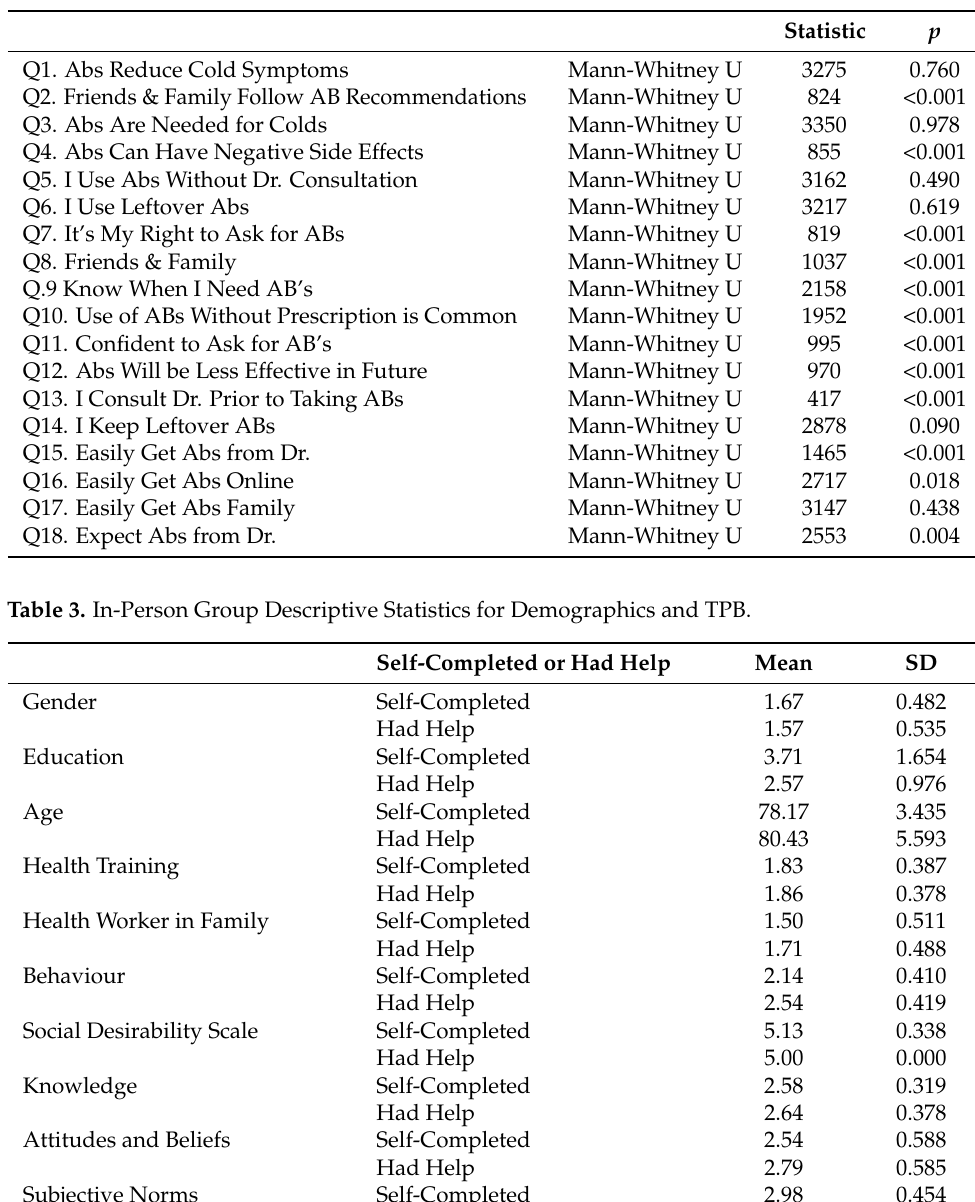
Table 2. Independent Samples T-Test—Mann–Whitney U For TPB Items.